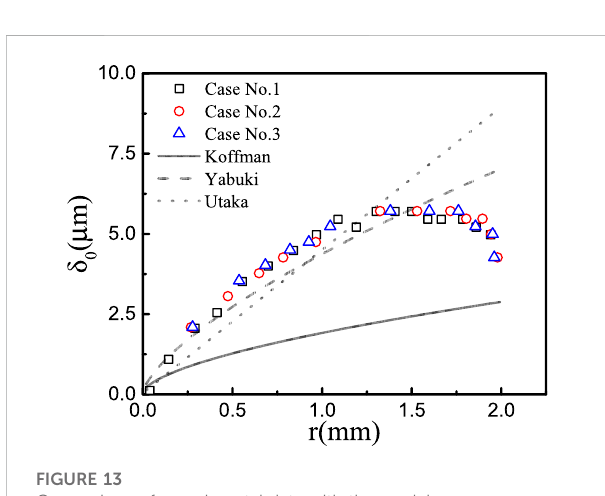
FIGURE 13 Comparison of experimental data with the models. FIGURE 14